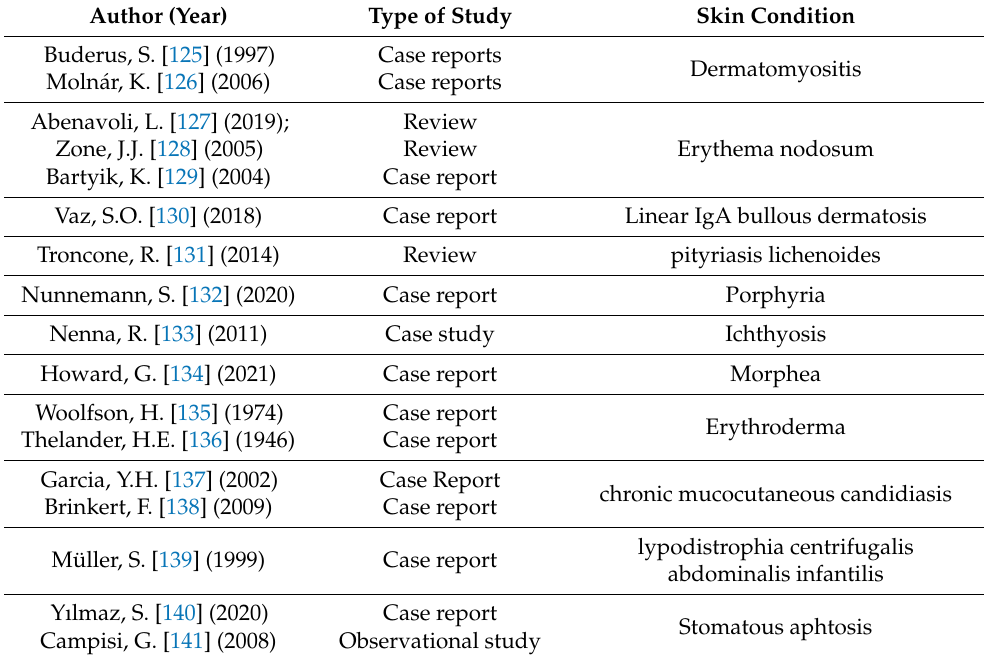
Table 1. Other skin condition associated to